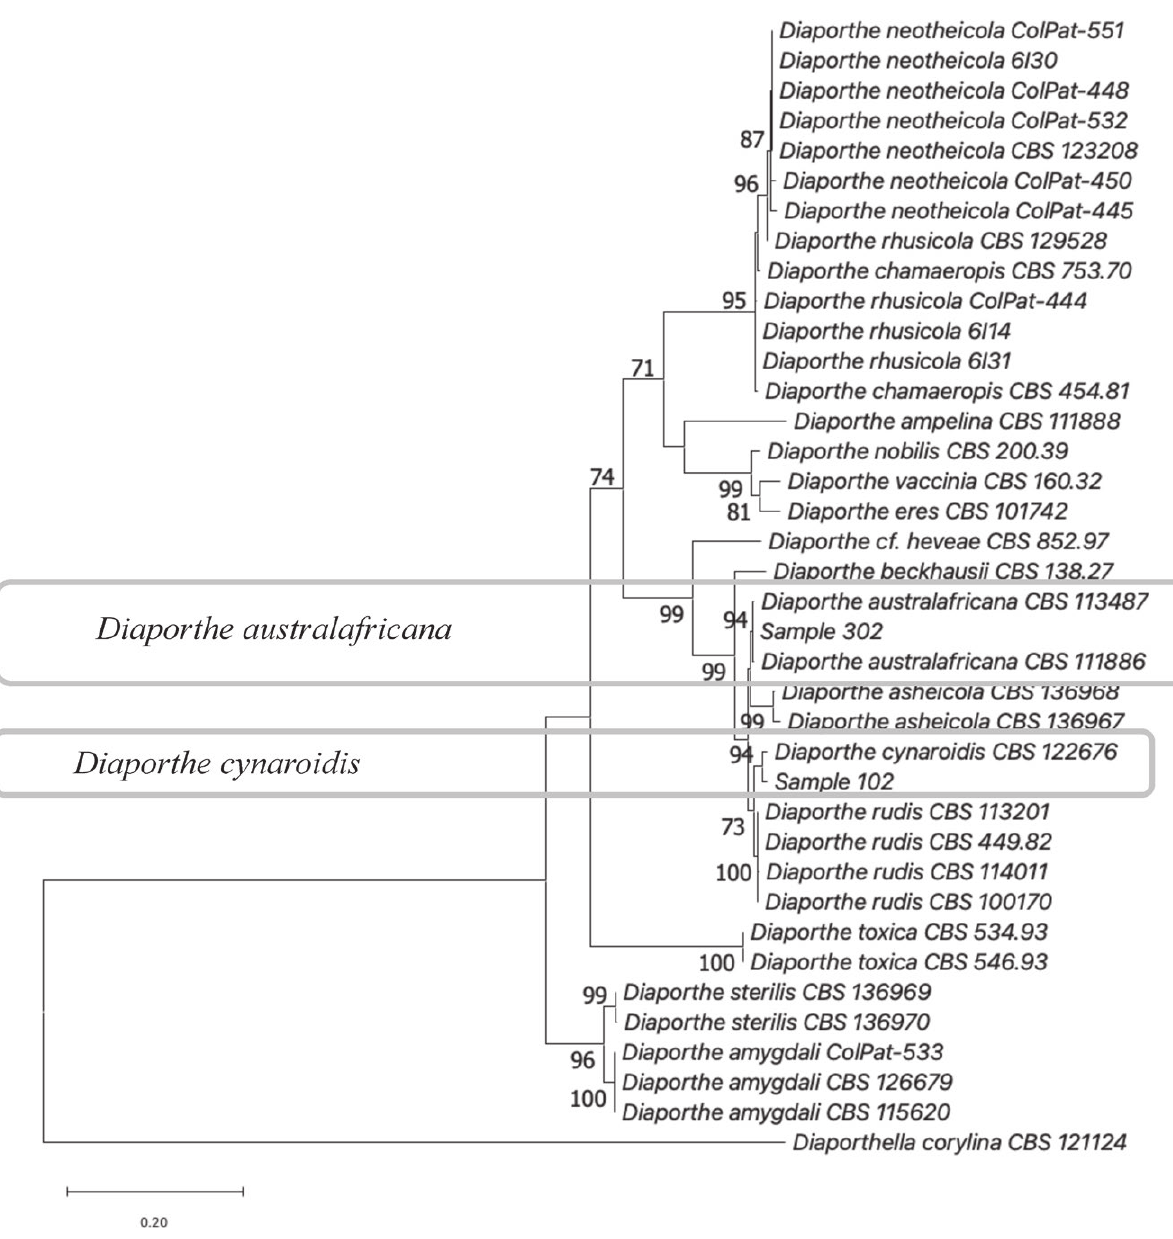
Figure 3. Phylogenetic tree reconstructed by maximum likelihood analysis from the concatenated sequences of the nuclear ribosomal inter- nal transcribed spacer, translation elongation factor and beta-tubulin for two Diaporthaceae taxa recovered from two walnut orchards in Chile, and 36 Diaporthe reference sequences retrieved from the GenBank database. The tree is drawn to scale, with branch lengths meas- ured in the number of substitutions per site. Numbers on branches are bootstrap support